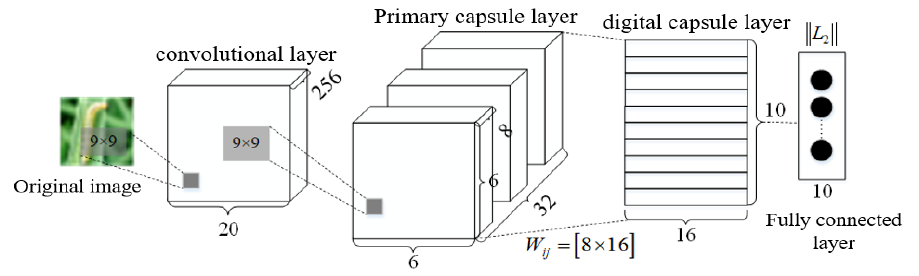
Figure 3. The architecture of CapsNet.